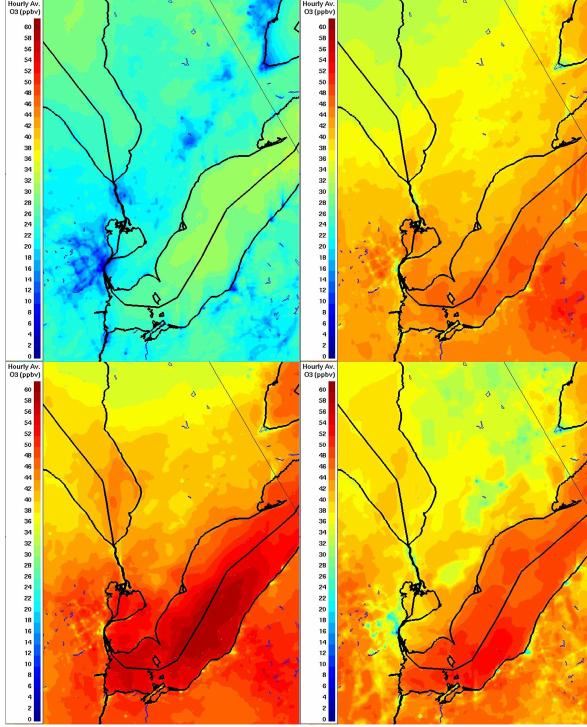
Fig. 18. 23-day average ozone concentration fields at (a) 12:00 UT, (b) 16:00 UT, (c) 20:00 UT, and (d) 00:00 UT; 08:00 a.m., 12:00 p.m., 04:00 p.m., and 08:00 p.m.,